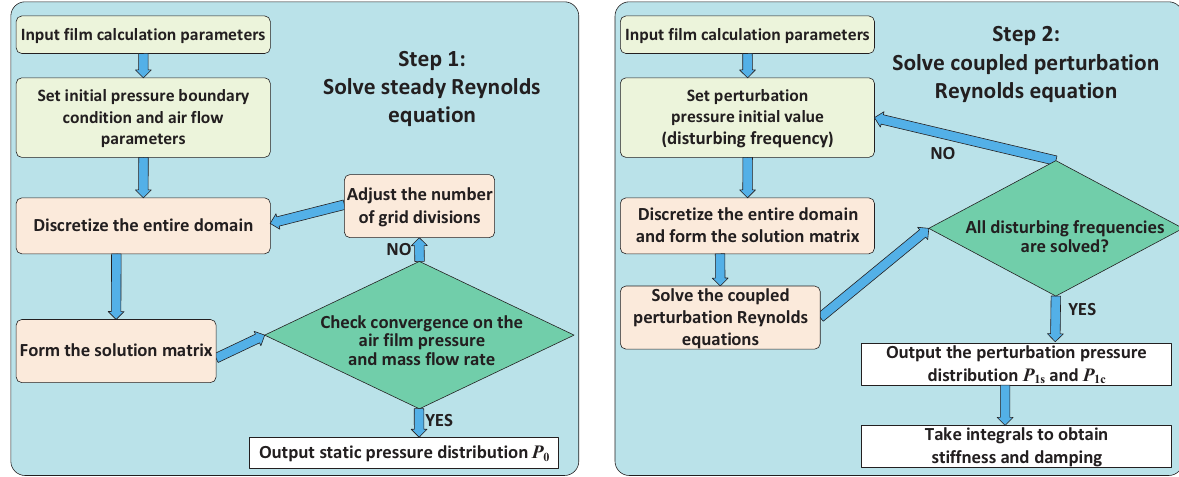
Figure 8. Flowchart of the calculation procedure.